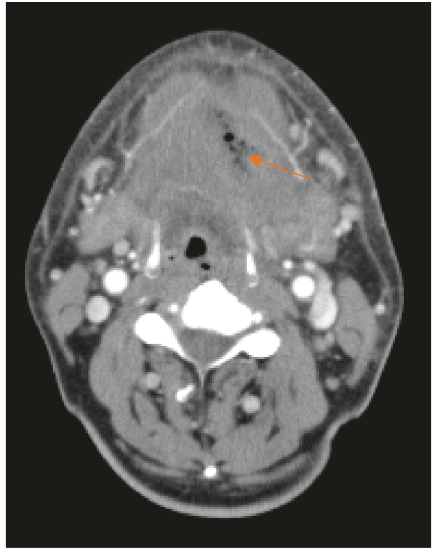
Figure 3: Typical CTimage in the first examination. Gas was noted in the left submandibular region over the submental region.